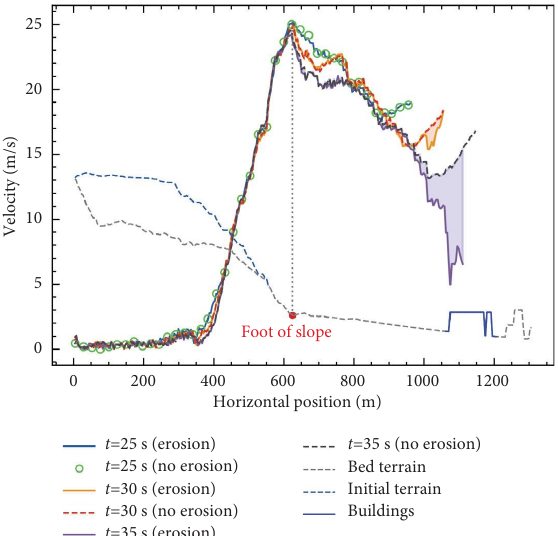
Figure 10: Te velocity characteristics of the landslide along the profle curve ( yellow line in Figures 3(b) and 6).